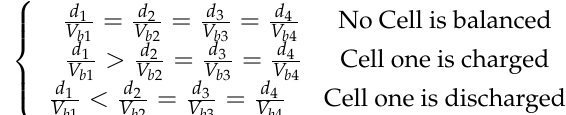
Figure 5. Battery equivalent circuit model.